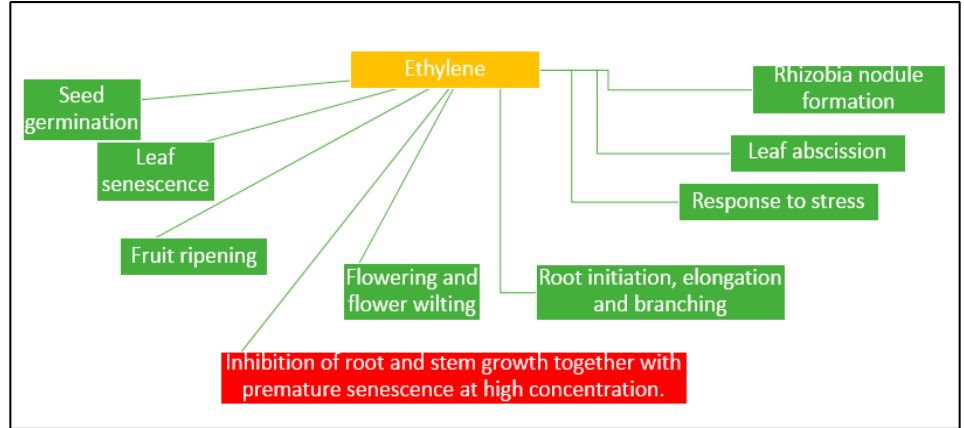
Figure 1. The phytohormone ethylene affects a large number of different processes in the growth and development of a plant.